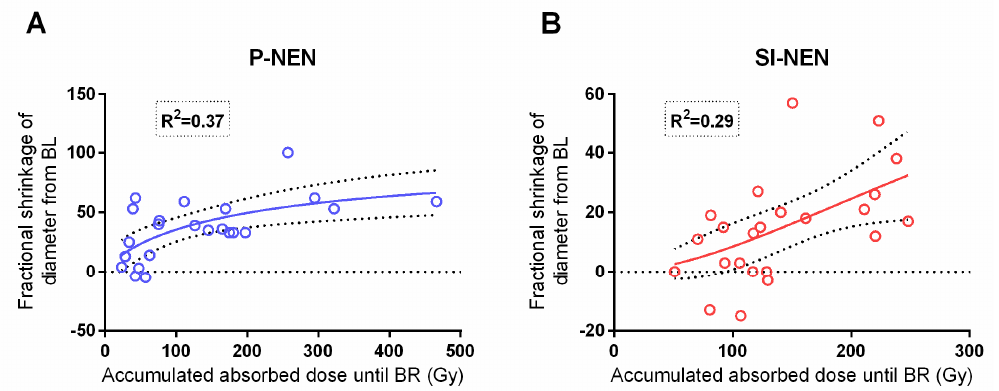
Cancers 2021 , 13 , x FOR PEER REVIEW 9 of 15